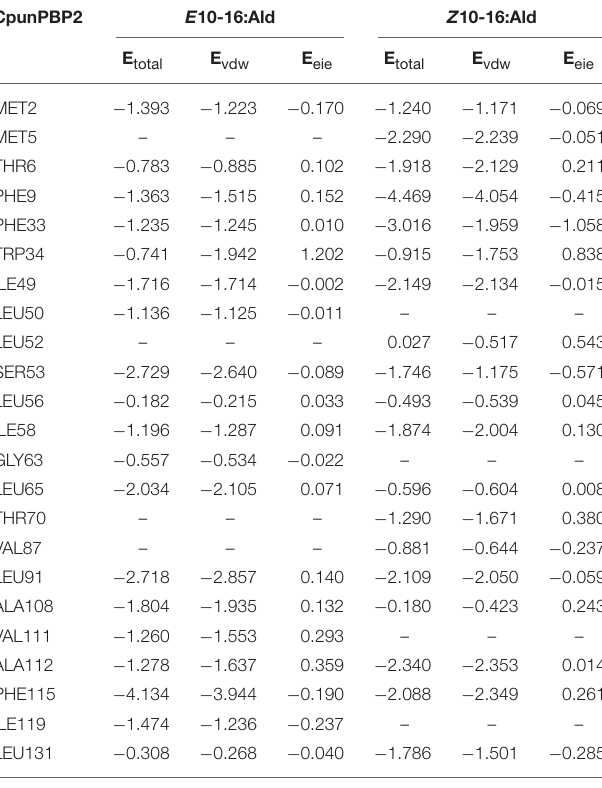
TABLE 2 | Interaction energies (k cal /mol) between the key residues of CpunPBP2 and pheromone compounds.